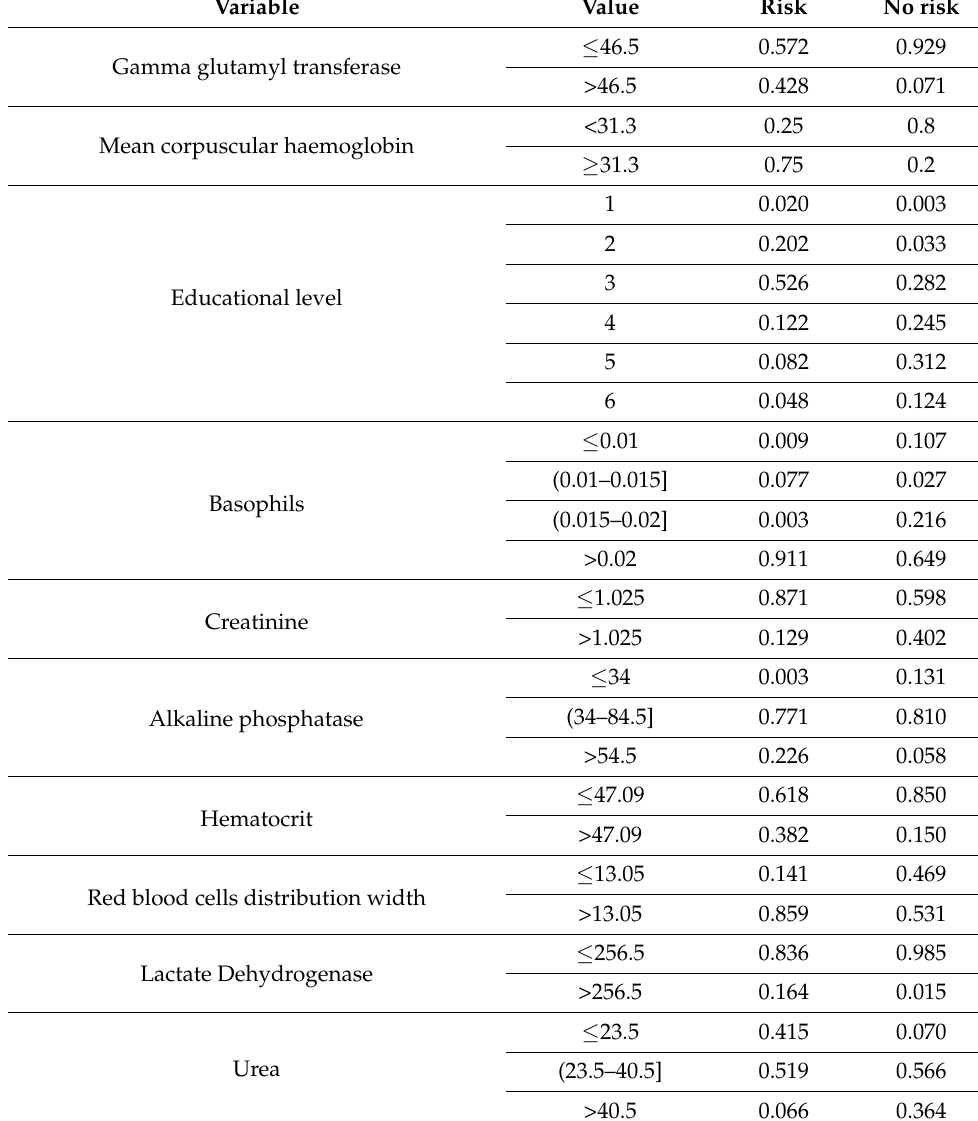
Figure 5. Prediction of alcohol use by 9 biomarkers and the study level using machine learning, obtained by a Bayesian network. BAS = Basophils, CREA = Creatinine, ALP = Alkaline phosphatase, GGT = Gamma glutamyl transferase, MCH = Mean corpuscular haemoglobin, HCT = Hematocrit, RDW = Red blood cells distribution width, LDH = Lactate Dehydrogenase. Table 3. Probability table for risk and the discretized variables in the Bayesian